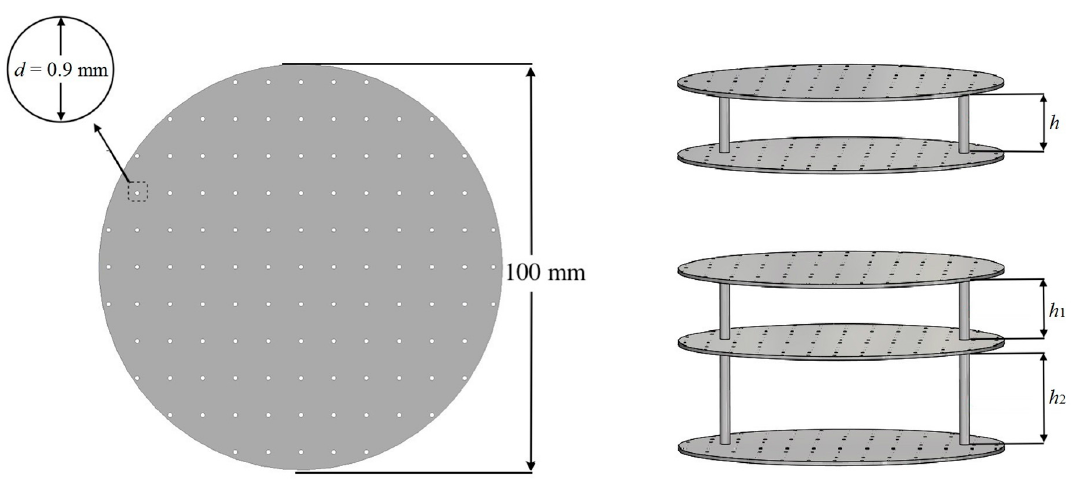
Figure 2. The schematic demonstration of the single-layer, double-layer, and triple-layer MPPs. The panel thickness t , perforation diameter d , perforation ratio p , and panel diameter of the panels were kept at 1 mm, 0.9 mm, 1.0 %, and 100 mm, respectively. The arrangement was made such that the inter-layer distances h (double-layer), h 1 , and h 2 (triple-layer) in Figure 2 could vary from 20 mm to 40 mm to quantify the e ff ects of di ff erent h on the e ff ective range of f and the absorption coe ffi cient α